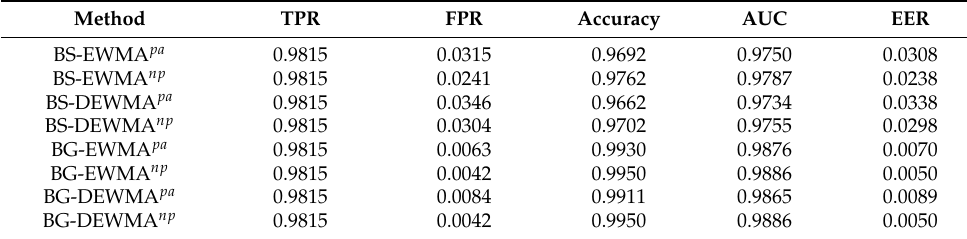
Table 8. Detection results by procedure when a circuit breaker fault occurred.